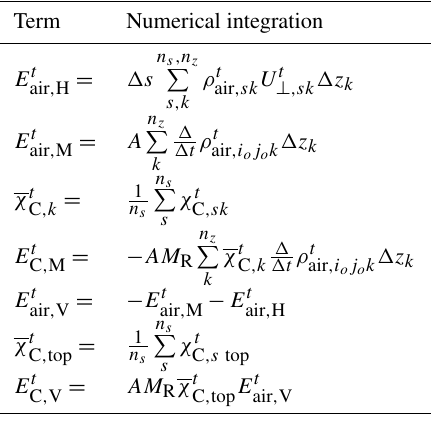
Table B2. Discrete integral expressions for Eqs. (B4) and (8)–(10) to be substituted in Eq. (12) for TR method estimations. Terms and variables are listed in the order needed for calculating the dependent terms. (cid:49)s is constant and equal to model horizontal grid resolution, 2.5km. t and s are time and path indices, respectively. A is the box base area. Point ( i o , j o ) is at the box horizontal